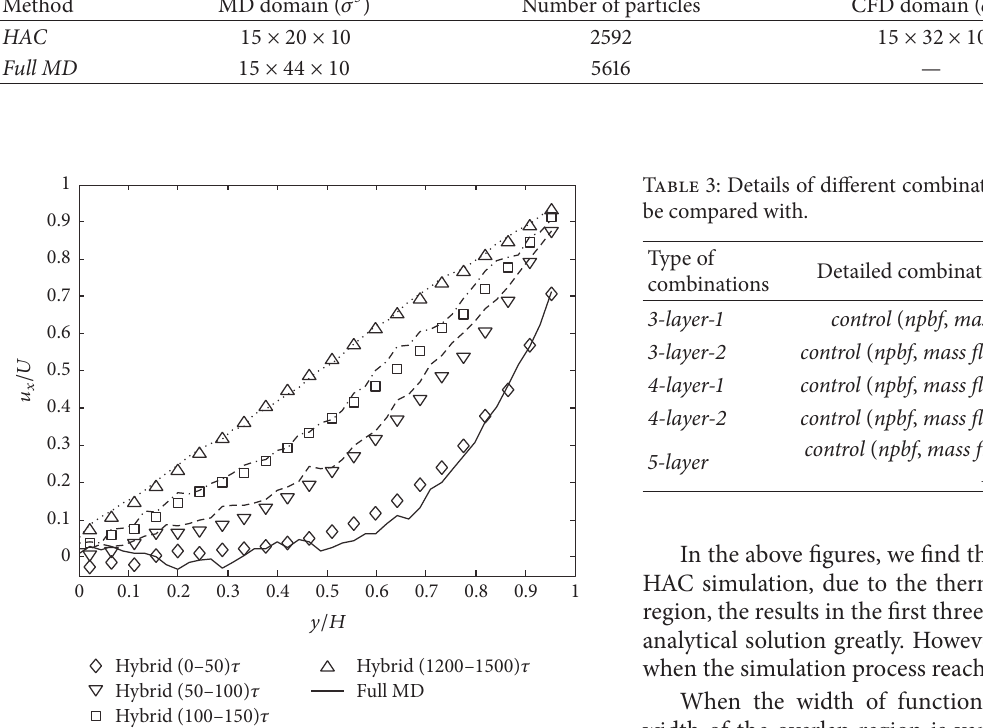
Figure 8: Velocity evolution profiles averaged over four time inter- vals compared with the full MD results.